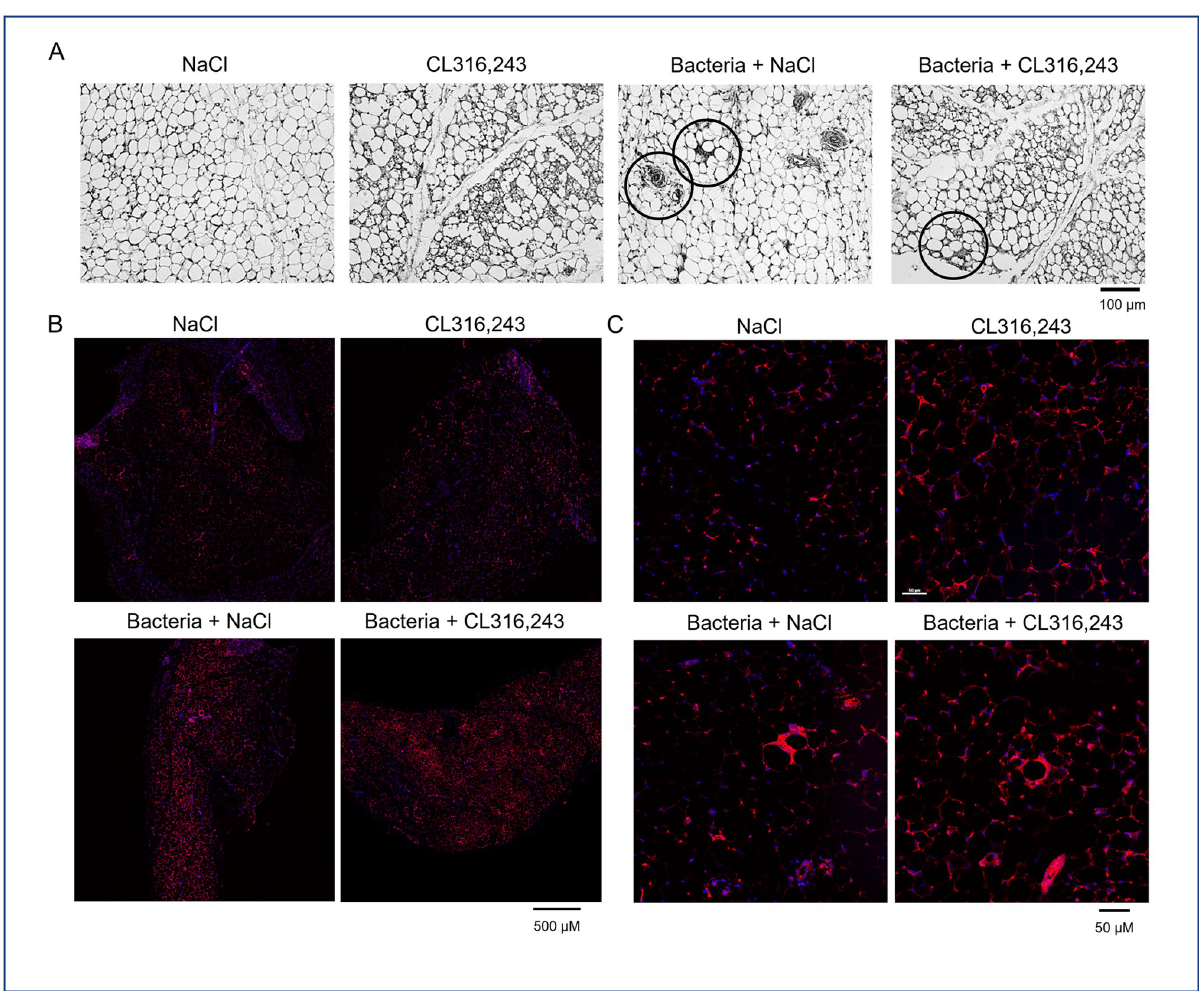
Fig 6. Histological characterization of scWAT infiltration by immune cells. (A) Representative pictures of four haematoxylin-eosin staining of sub- cutaneous white adipose (scWAT) tissue of mice treated or not with CL316,243 (1 mg/kg/day; 1 week) and infected 48 hours with E . coli . Typical figures of immune cell infiltration and crown structure are black circled. (B, C) Low and high magnification of F4/80 immunostaining (in red) in scWAT of the same mice. Scale bars are indicated.